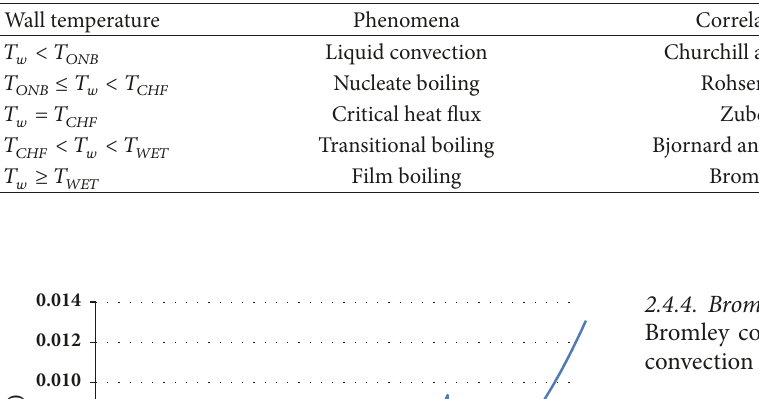
Table 1: Boiling heat flux models.